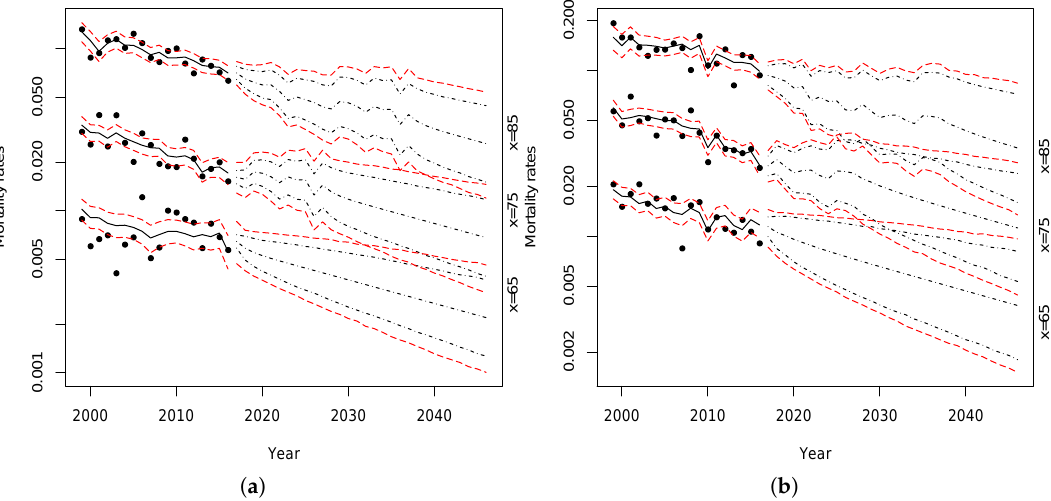
Figure 18. Mortality rate projections at age 65, 75, 85 with parameters uncertainly with the APC model for ( a ) female Maltese population, ( b ) male Maltese